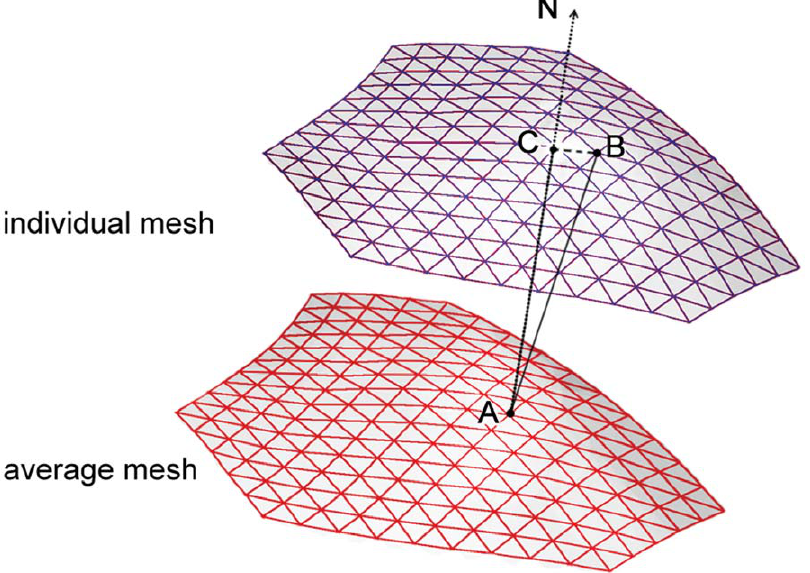
Figure 2. Demonstration of direct displacement and normal displacement. The red surface mesh represents the altas surface constructed from all subjects, and the purple is an individual surface. Point A and B represent two corresponding points on the two surfaces. The black segment between point A and point B represents the direct displacement vector. N is the normal direction of point A on the average surface. The black segment between point A and point C represents the normal displacement (i.e. the projection of the direct